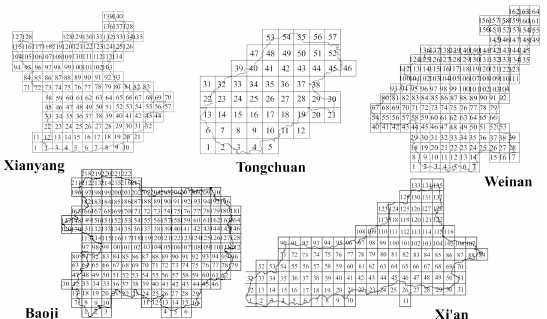
Figure 1. Mesh division diagram of Xi’an, Baoji, Tongchuan, Weinan and Xianyang.